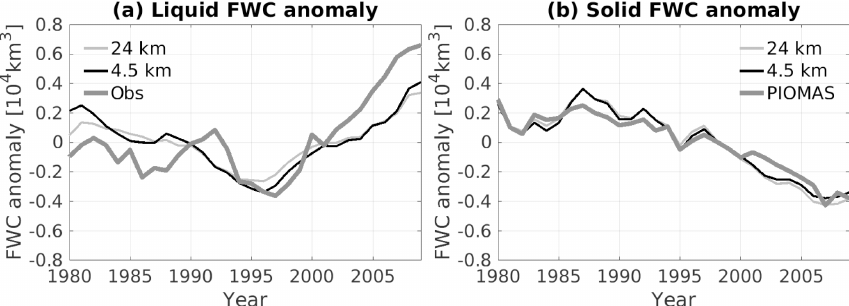
Figure 12. Anomalies of annual mean (a) liquid FW content and (b) solid FW content of the Arctic Ocean relative to the mean of the plotted period. The FW content is calculated using a reference salinity of 34.8. The liquid FW content observation is provided by Polyakov et al. (2013a), and the solid FW content is compared to the data derived from PIOMAS reanalysis (Schweiger et al., 2011). The time period from 1980 to 2009 is